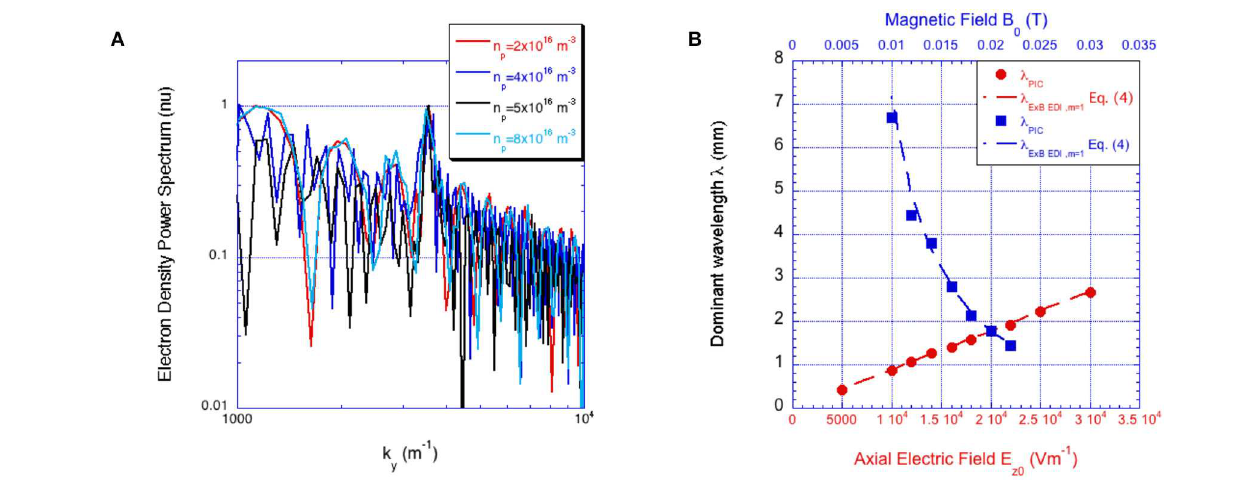
FIGURE 11 | (A) Amplitudes (normalized to the maximum) of n e spectral components k y using four different electron density. (B) Dominant wave detected in the non-linear phase as a function of magnetic field B 0 (blue circles using E z0 correspond to input data reported in Table 1 and using the following numerical parameters N ppc